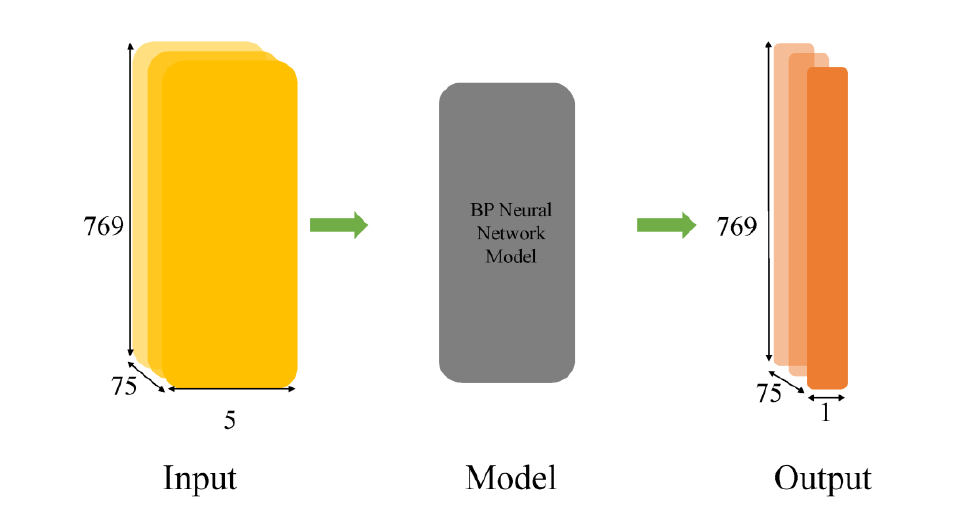
Figure 6. Input and output of the BP neural network model.